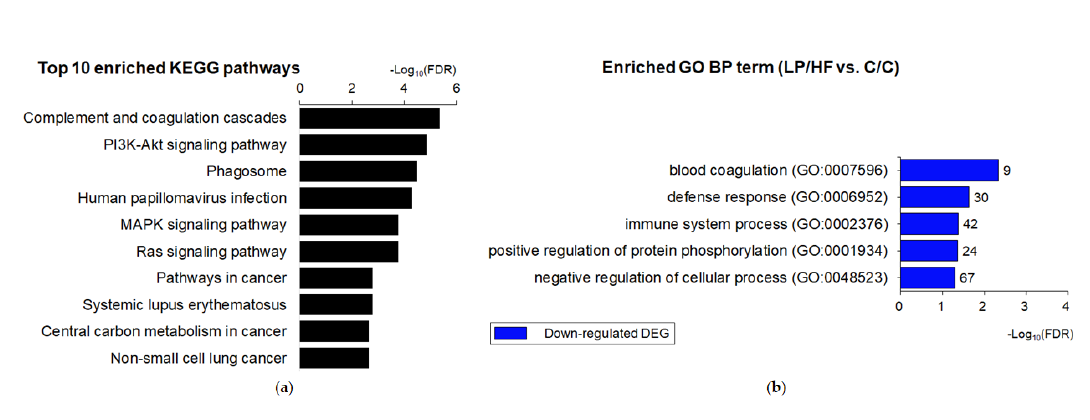
Figure 4. Functional enrichment analysis of the list of differentially expressed genes (DEGs) between LP/HF and C/C groups. ( a ) Top 10 enriched of Kyoto Encyclopedia of Genes and Genomes (KEGG) pathway of both up-and down-regulated DEGs were selected and sorted by descending order of –log10(FDR). ( b ) Gene ontology (GO) annotations of down-regulated DEGs based on biological process (BP). The unique specific biological process (BP) terms are selected and sorted by descending order of –log10(FDR). The number of DEGs associated with the listed GO term is indicated at the edge of each bar.